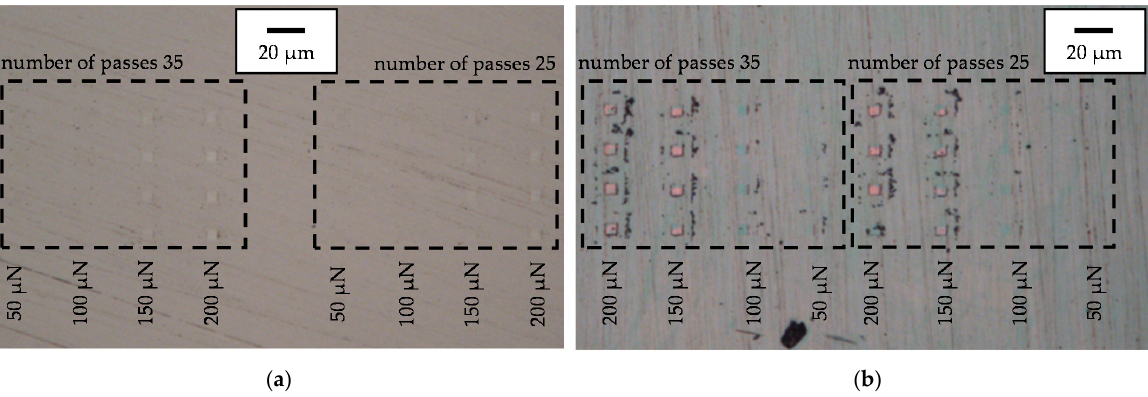
Figure 14. Light microscope images of the measuring locations for wear patches of the series with 35 P and 25 P: ( a ) For the Mo ‐ coating; ( b ) For the MoO 3 ‐ coating.